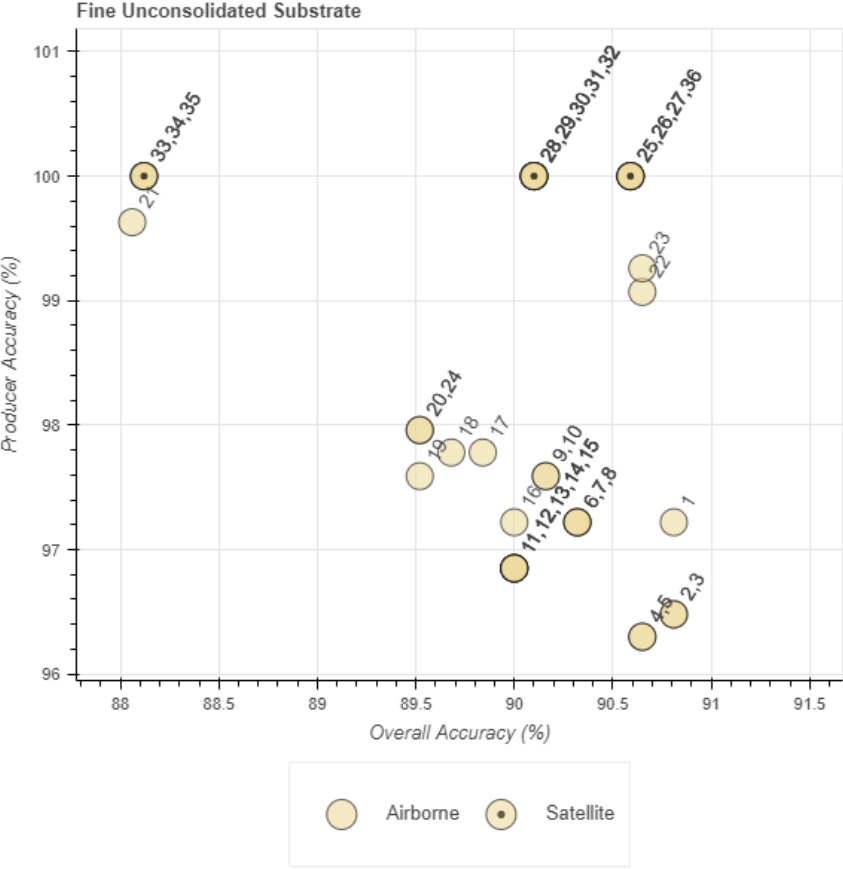
Figure 11. Tier 1 plot of fine unconsolidated substrate classification performance, comparing percent overall accuracy and percent producer accuracy for airborne and satellite data combinations. Number labels refer to unique classification input data combinations identified in the Index field in Table A1, Appendix A.